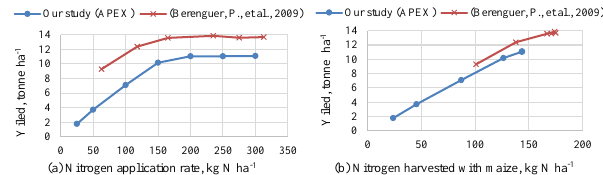
Figure 10. The maize yield simulated in our study in relation to N application rate (a) and N harvested with maize (b) in comparison to the maize yields from field experiments by Berenguer et al. (2009) when corrected for zero N build-up in the root